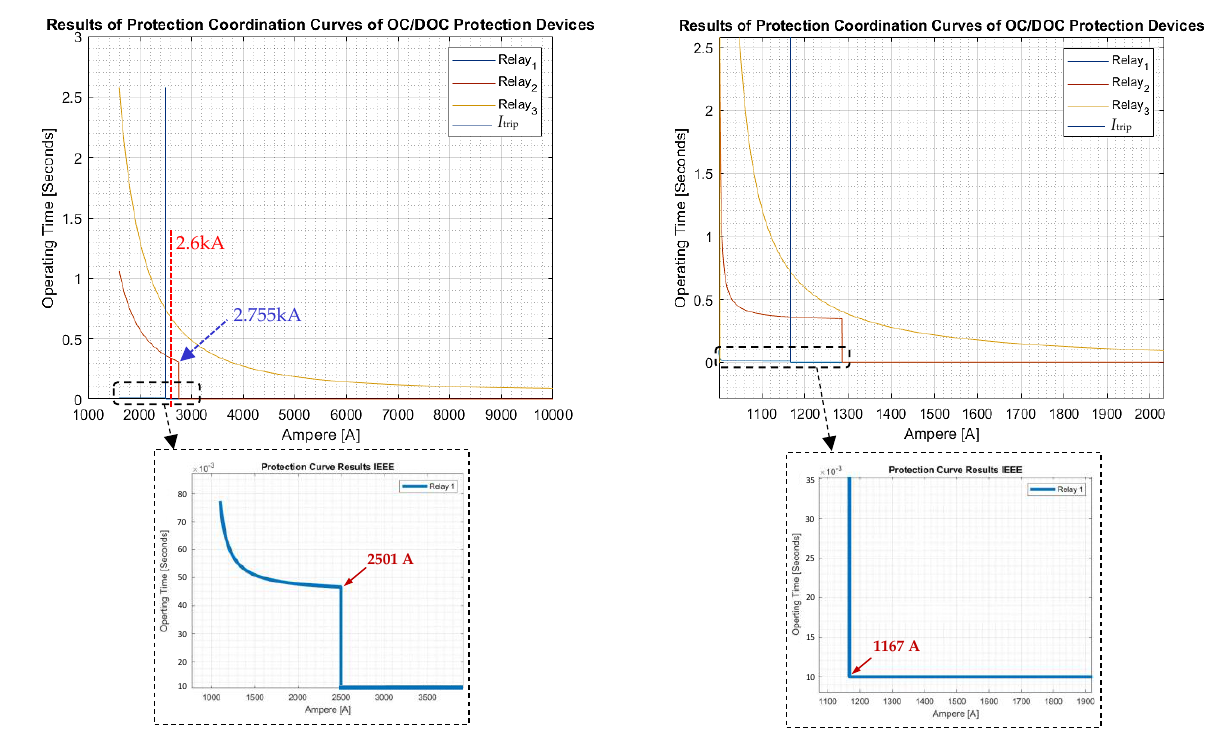
Figure 12. Optimal protection characteristic curves of the OC relays in Scenario 2 of the 22 kV distribution system.